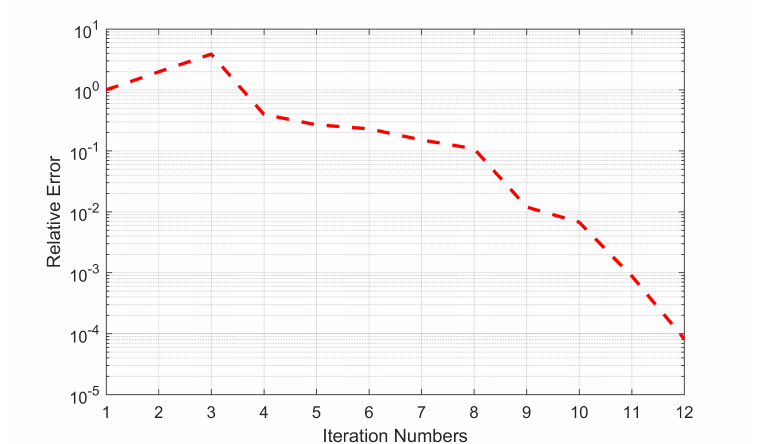
Figure 3. Typical convergence behavior of the proposed adaptive